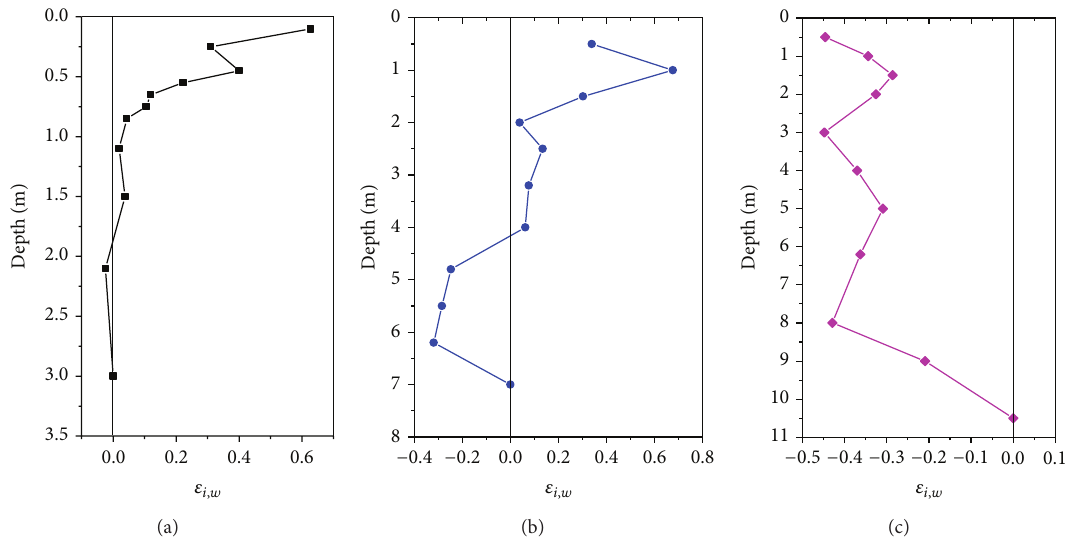
Figure 4: Calculated strains of black shale by immobile element Ti in Chengkou County. (a) Profile A, (b) profile B, and (c) profile C.